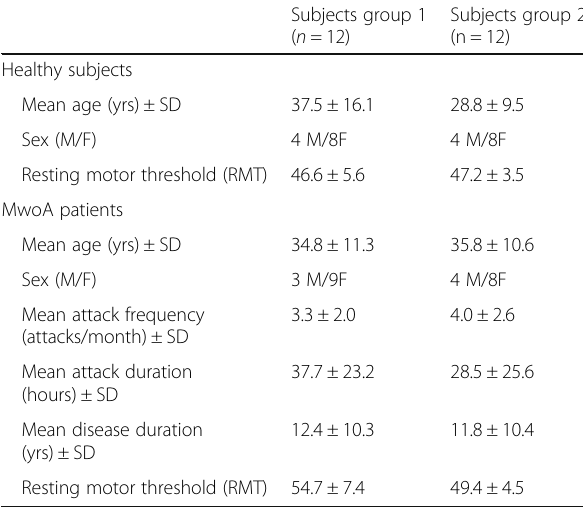
Table 1 Demographic and clinical characteristics and resting motor threshold (RMT) values of the enrolled subjects